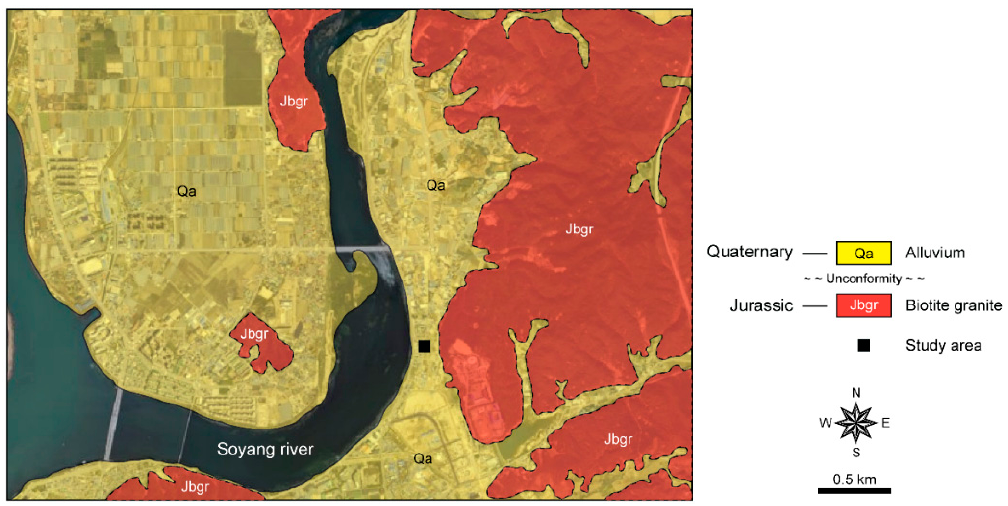
Figure 1. The geologic map of the study area.